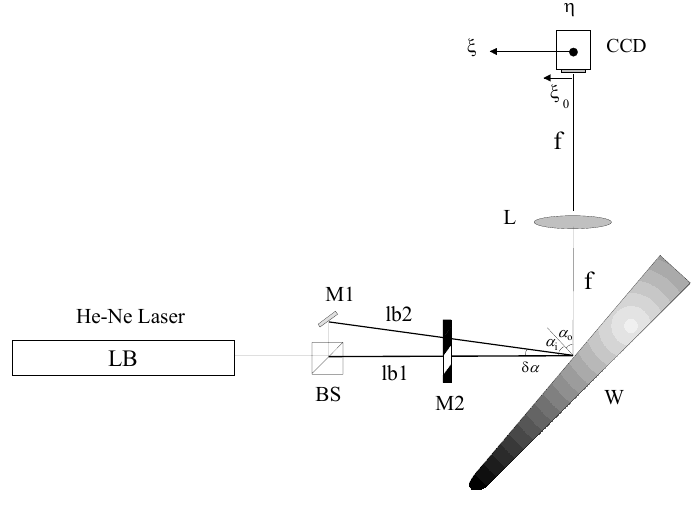
Figure 1. Layout. ( a ) LB, laser beam; ( b ) BS, beam splitter; ( c ) M1, Mirror; ( d ) M2, gradual mirror; ( e ) W, wing (sample); ( f ) L, lens; ( g ) CCD, detector; ( h ) , d ifference angle of the two beams; ( i ) f , focal length; ( j )  and  , CCD coordinate system; ( k ) lateral displacement of the CCD camera.